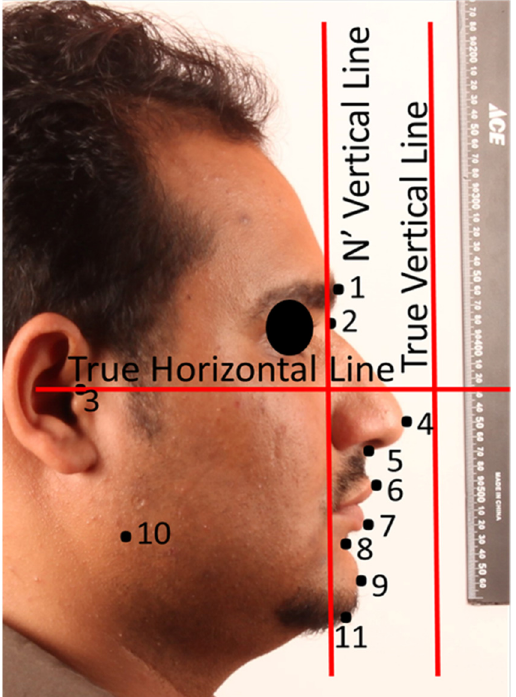
Figure 2. The facial profile soft tissue landmarks and main reference planes used in the study.